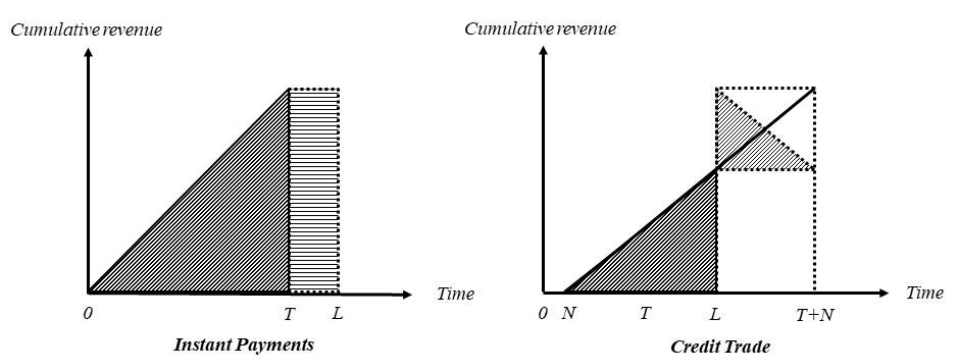
Figure 2. Graphical representation of L − N ≤ T ≤ L